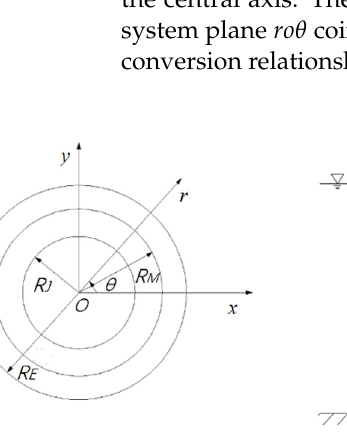
Figure 1. MJWEC and its basin division.